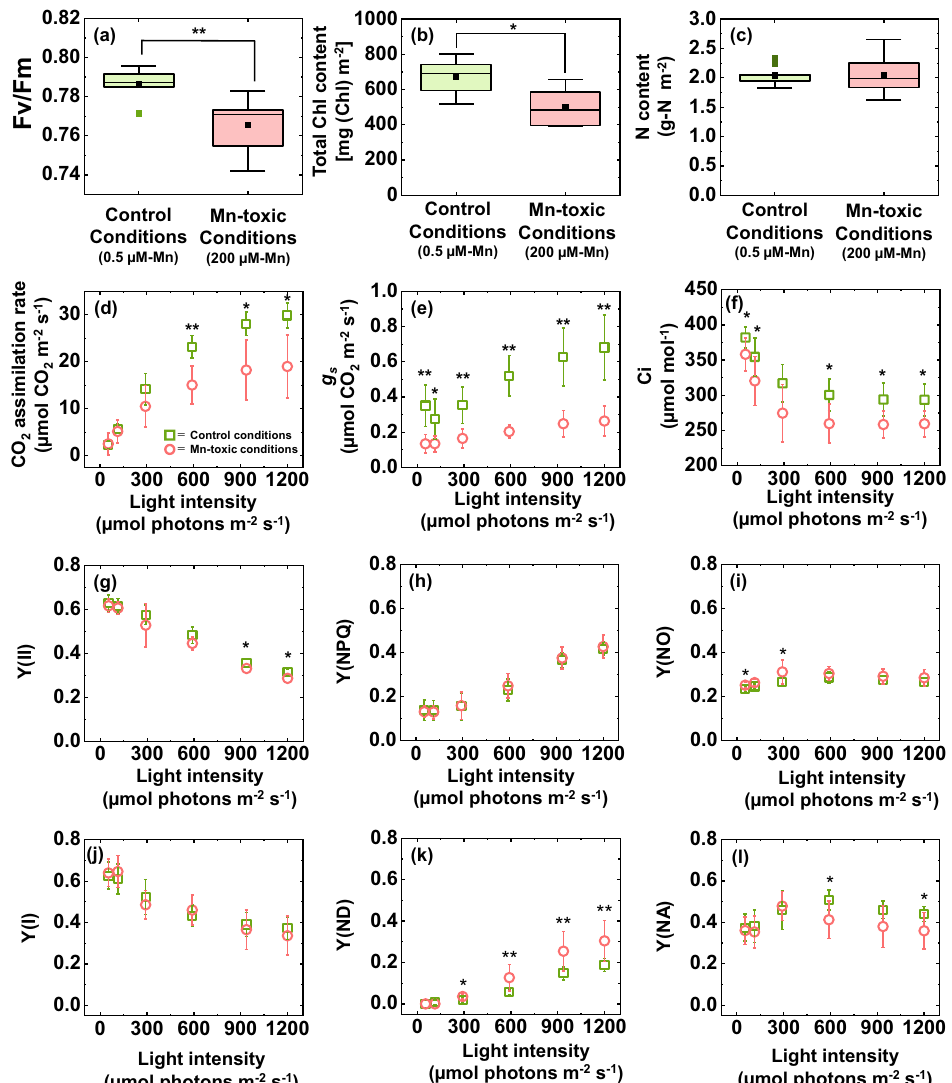
Figure 3. Photosynthetic activities in leaves grown under control and Mn-toxic conditions. The maximum quantum yield of PSII (Fv/Fm) is shown in ( a ). ( b , c ) Show the total Chl and N concentrations in the leaves, respectively. The CO 2 assimilation rate ( d ), stomatal conductance ( g s ) ( e ), and intercellular CO 2 concentration ( f ) are shown. For the PSII photosynthetic parameters, the quantum yields of PSII [Y(II)] ( g ), non-photochemical quenching [Y(NPQ)] ( h ), and non-radiative decay [Y(NO)] ( i ) are shown. For PSI photosynthetic parameters, the quantum yields of PSI [Y(I)] ( j ), non-photochemical quenching at the donor side [Y(ND)] ( k ), and non- photochemical quenching at the acceptor side [Y(NA)] ( l ) are shown. Data of photosynthetic parameters are shown as means with standard deviation (SD) (n = 7). The results for Fv/Fm (n = 7) and total Chl (n = 7) and N (n = 9) concentrations are shown as box plots. All data were obtained from independent biological replicates according to the indicated numbers. Black squares indicate the mean value, and bars indicate the range of the maximum or minimum data within a 1.5 × interquartile range (IQR). Asterisks show significant differences between the control and Mn-toxic conditions (* p < 0.05, ** p < 0.01, Kruskal–Wallis